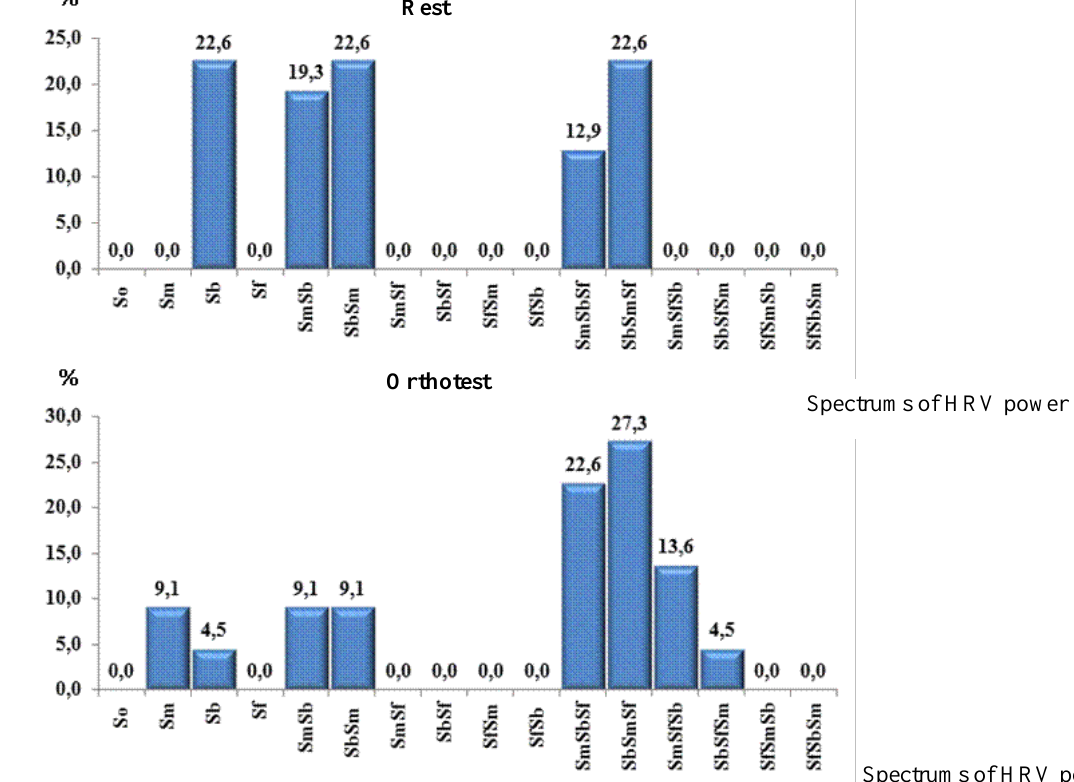
Fig. 1. Distribution of types of power spectrums of HRV in rest and under functional loads (AFL) of sportsmen without CT